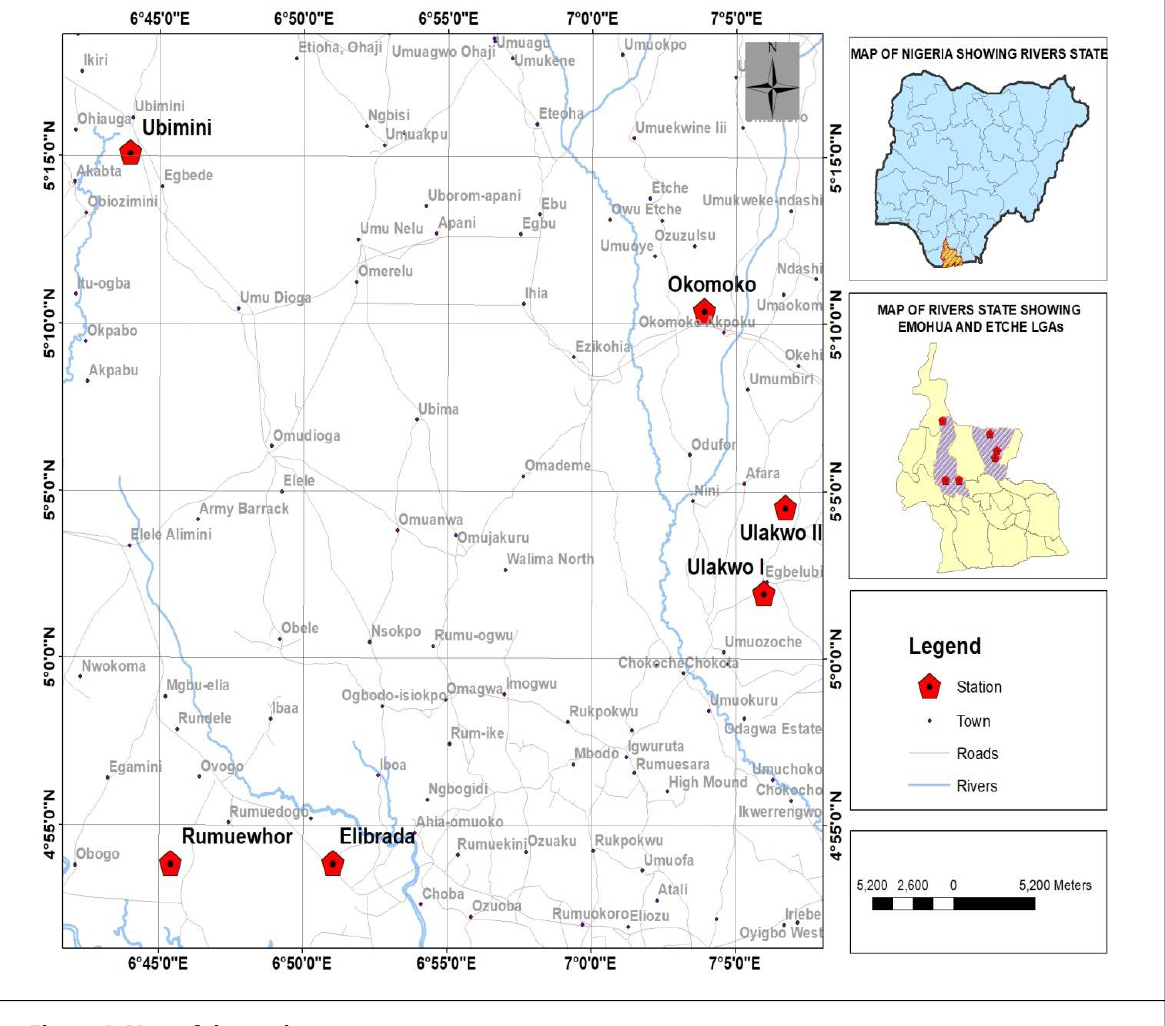
Figure 1: Map of the study